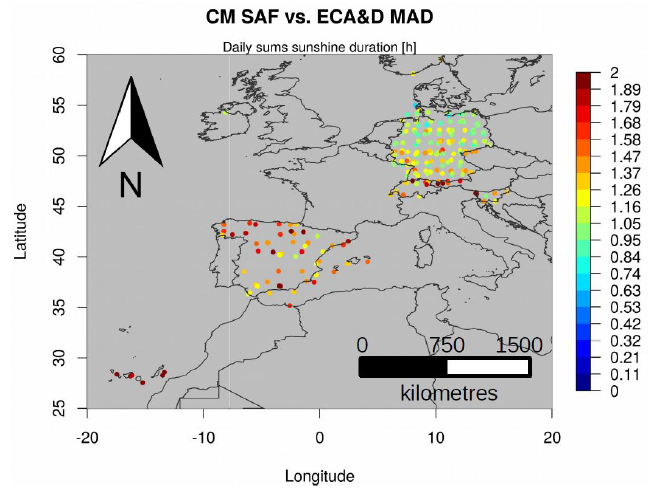
Figure 3. Spatial distribution of the MAD (h) between daily SDU and ECA&D for the time period 1983 to 2015.